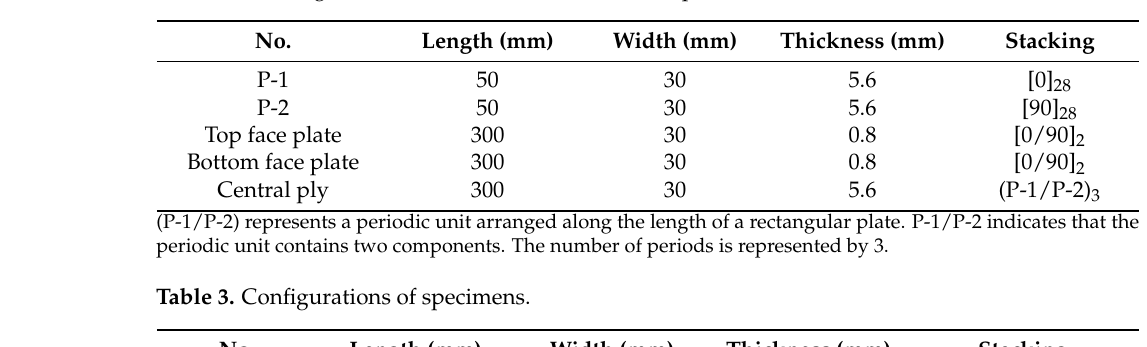
Table 2. Stacking method of the CFRP laminate with periodic structures.